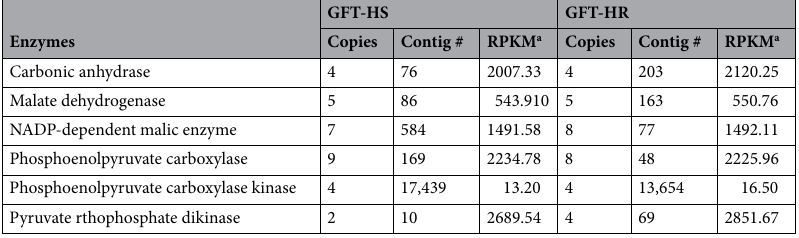
Table 2. Genes involved in C4 biosynthesis in herbicide-susceptible (HS) and -resistant (HR) biotypes of green foxtail (GFT). a RPKM = Reads Per Kilobase of transcriptome per million Mapped reads.